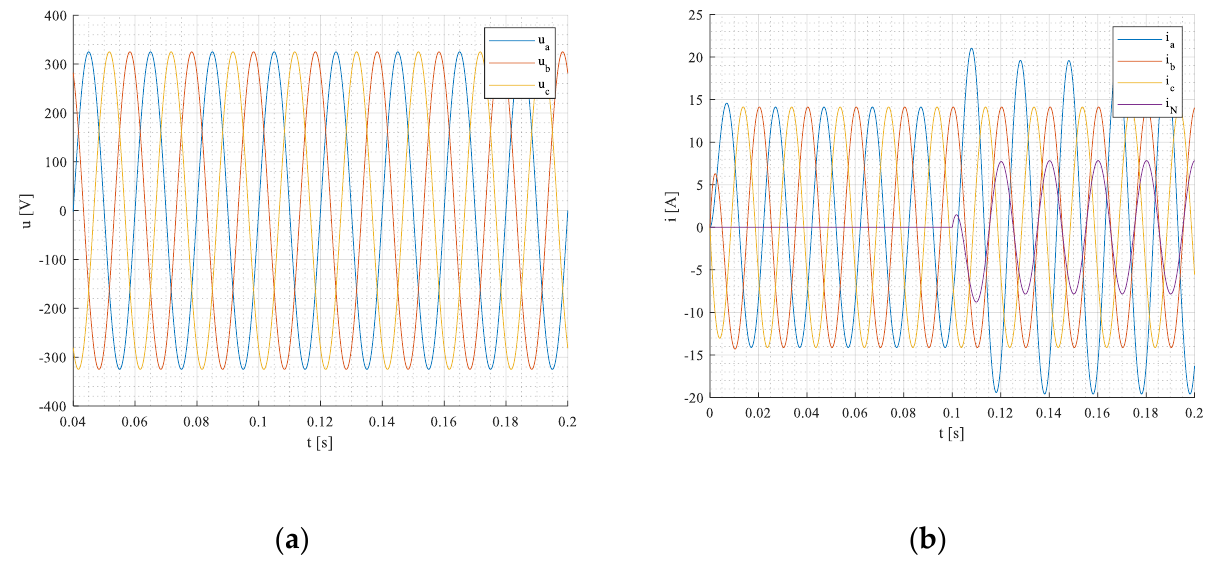
Figure 26. Network voltages ( a ), load, and neutral currents ( b ). Apparent, active, blind, and distortion power components during transient states for a 3 –phase system are shown in Figure